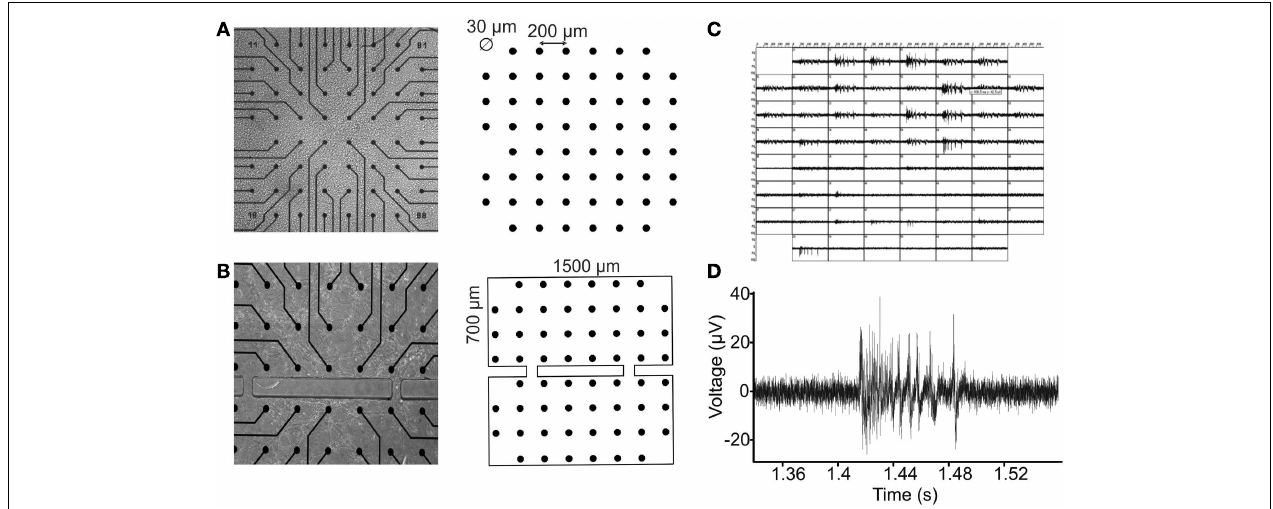
bi-compartmental system realized in PDMS with two interconnection microchannels. Compartments height is 700 µ m, and width is 1500 µ m. Microchannels height is 100 µ m, and width is 50 µ m. (C) Spontaneous electrophysiological activity of a confined culture of hippocampal neurons, registered from all the micro electrodes. (D) A typical hippocampal burst waveform recorded from a single